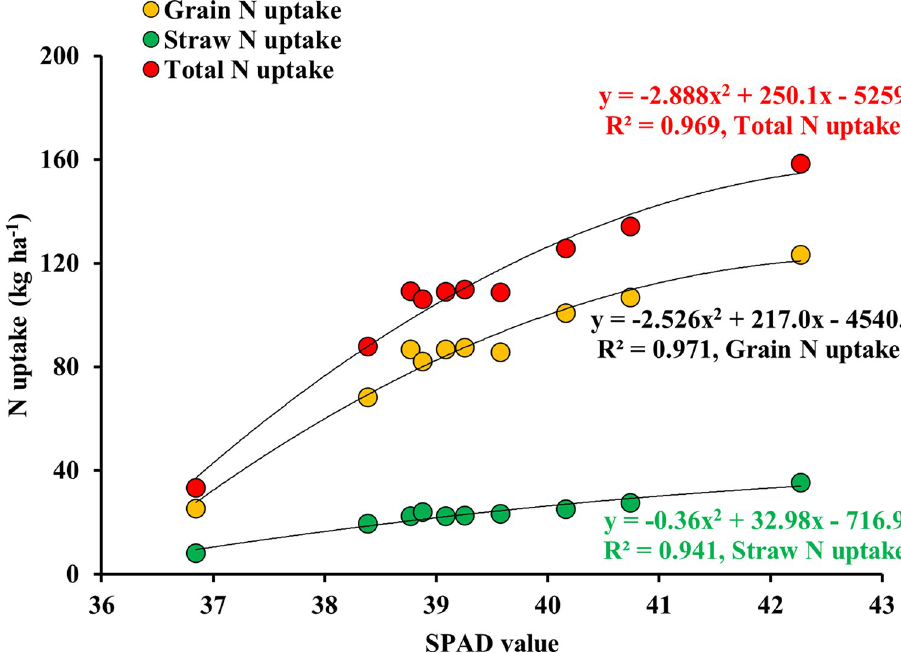
Fig 4. Quantitative relationship between SPAD value and N uptake (kg ha -1 ) by grain, straw and total (grain + straw) N uptake by wheat ( Triticum aestivum L.) in a sandy loam soil.